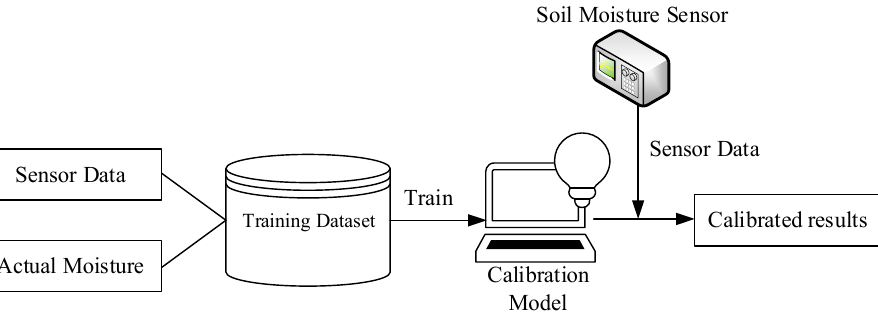
Figure 2. The framework of the proposed data-driven calibration method.